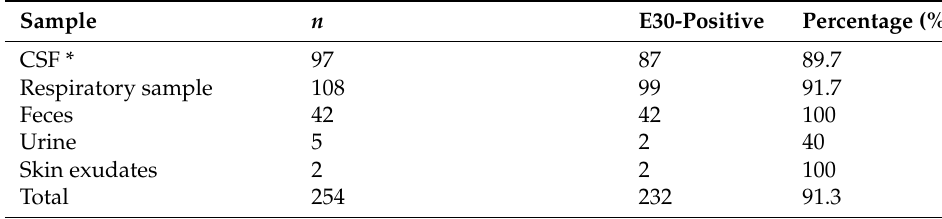
Table 2. Types of samples studied in 173 cases of E30